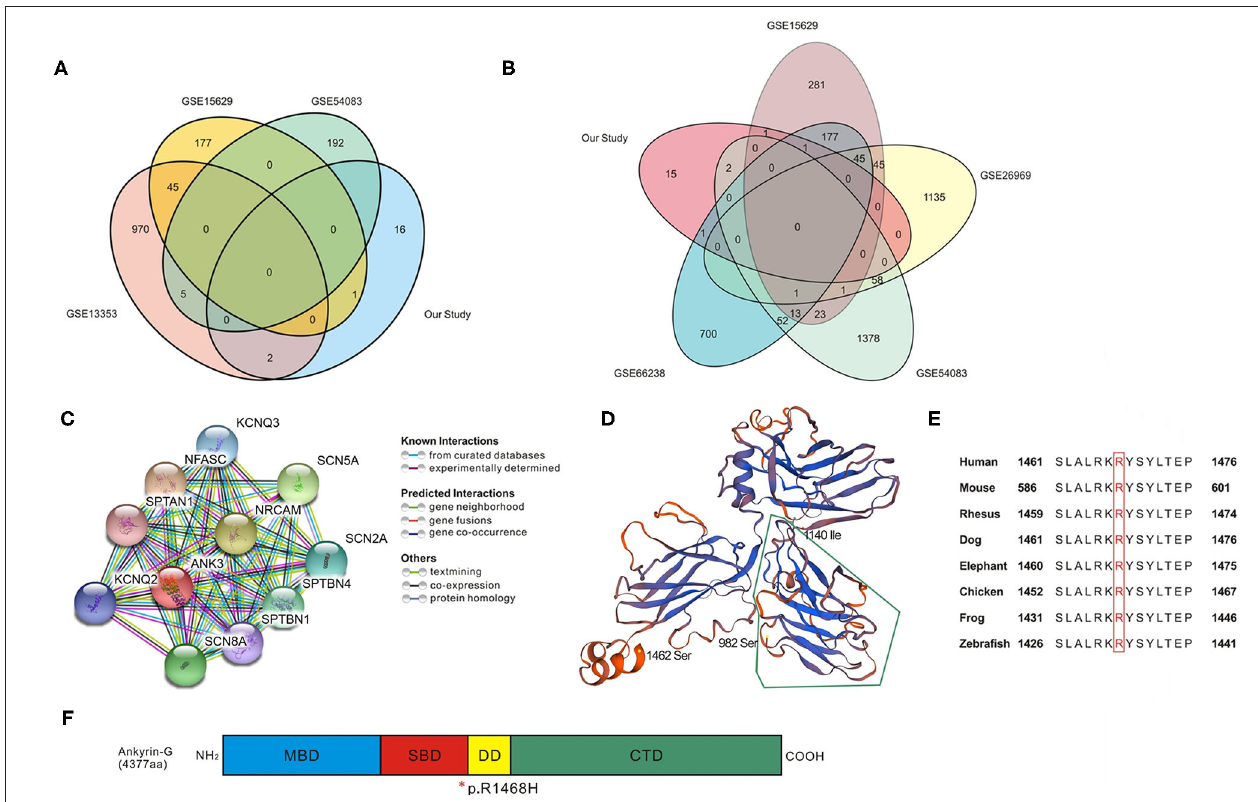
FIGURE 2 | Bioinformatic analysis for candidate genes. (A,B) Venn analysis in UIA vs. RIA groups and UIA vs. Control groups; details of overlapped genes are shown in Table 4 . (C) Protein–protein interaction network analyzed using STRING database. The network codes represent the proteins produced by corresponding protein-coding genes which are mainly associated with ion channels. (D) Computational model of SBD domain (982–1,462 amino acids, seq identity 77.28%). The segment surrounded by green lines (982–1,140 amino acids) is critical in bridging spectrin/actin cytoskeleton. (E) Conservation alignment showing that the mutated amino acids of ANK3 are conserved among different species. (F) Schematic diagram depicting the domain structure of Ankyrin-G (4,377 amino acids in human). The membrane binding domain (MBD, colored in blue) is comprised of 24 ANK repeats folded into a super-helical structure. The spectrin-binding domain (SBD, colored in red) can coordinate integral membrane proteins to the membrane skeleton, and the variant discovered in our study is at the end of this domain. The death domain (DD, colored in yellow) is highly conserved and the C-terminal domain (CTD, colored in green) is the most variable region to modulate the affinity and cellular localization of binding partners with ankyrin. *, the location of p.R1468H in the end of SBD domain.